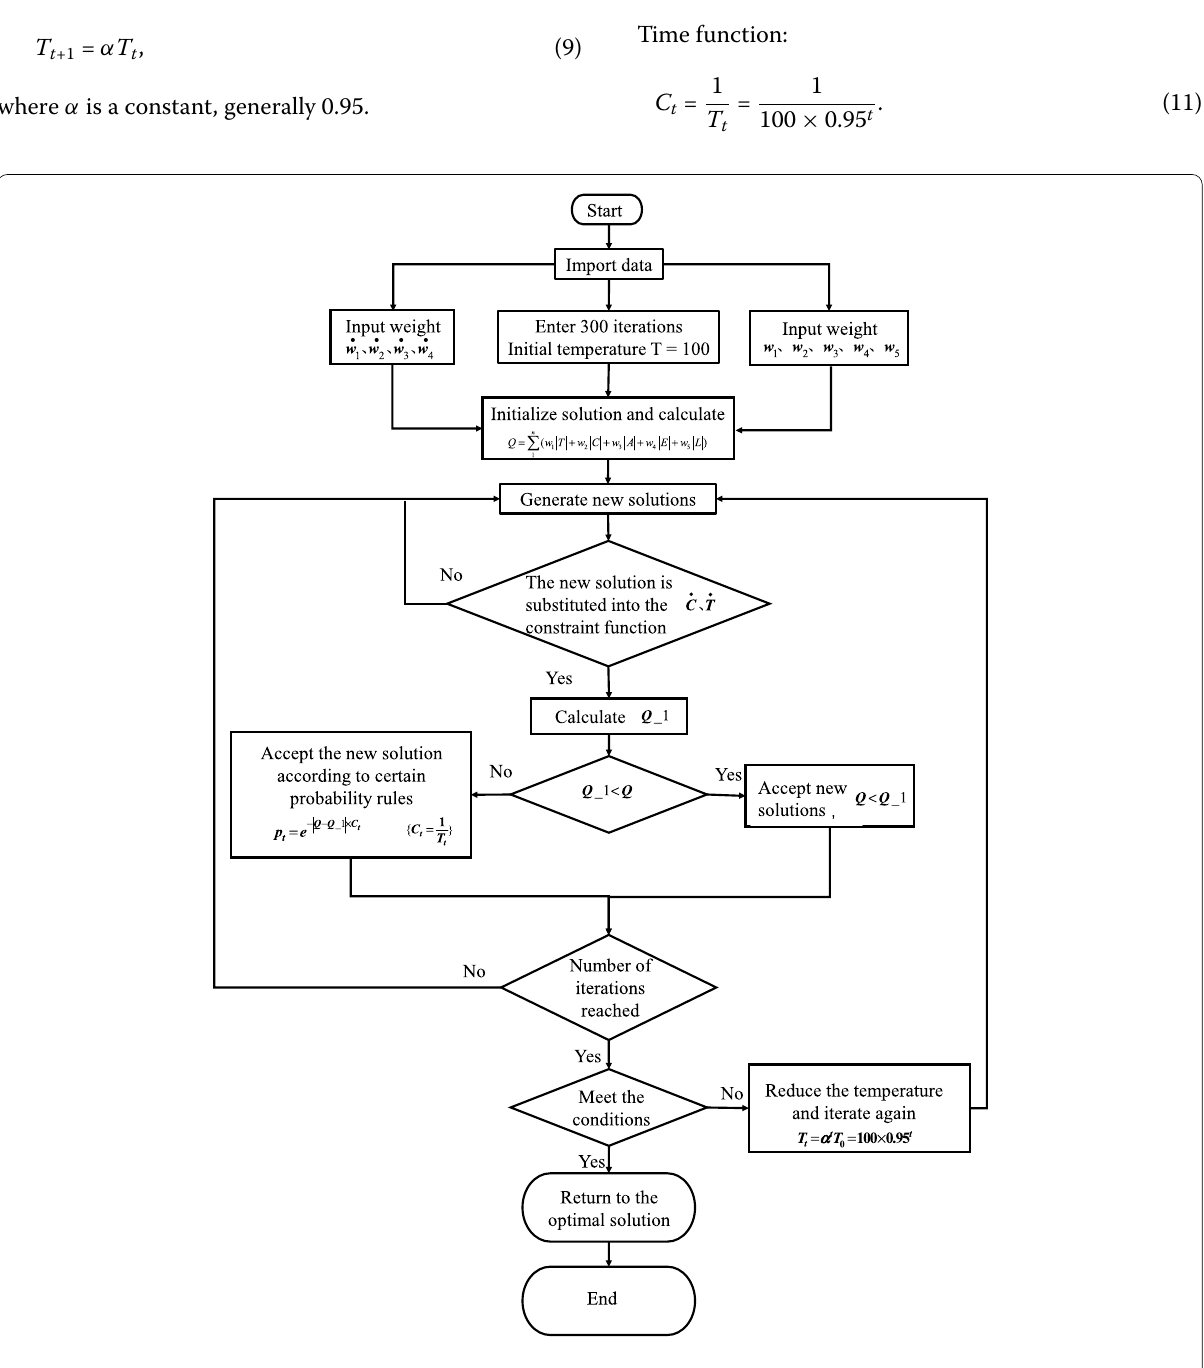
Figure 4 Flow chart of simulated annealing